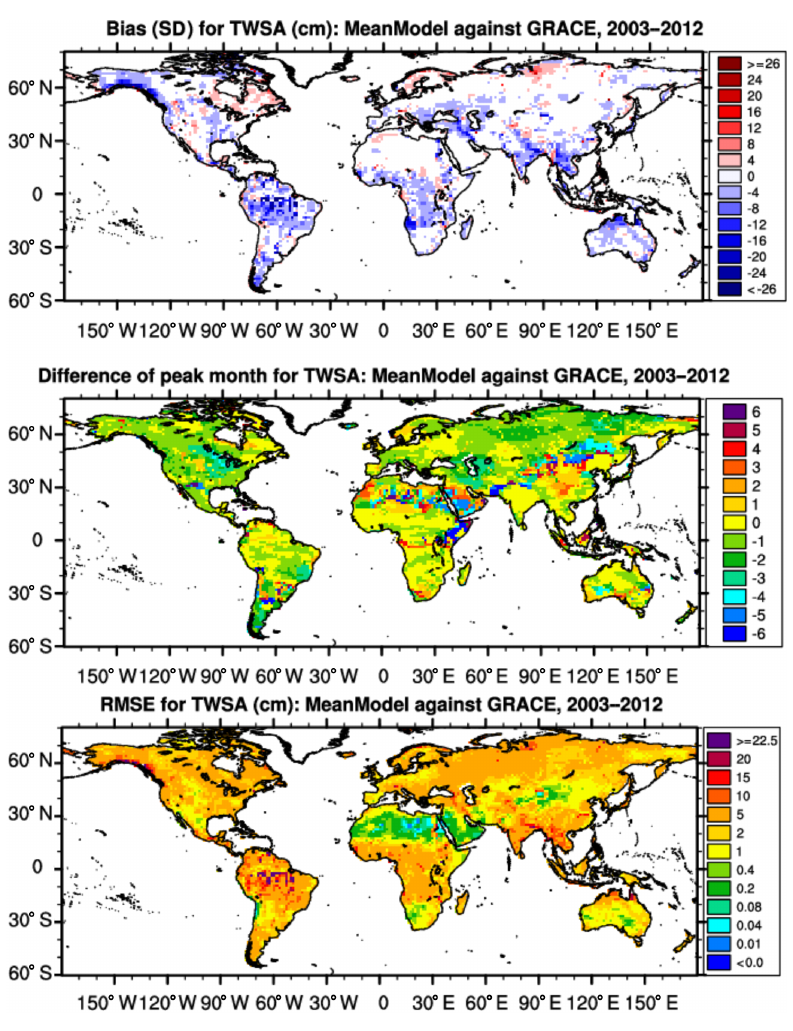
Figure 5. Terrestrial water storage anomaly metrics for the ensemble mean, from top to bottom: SD of bias, phase difference (months) and root mean square error. Table 5. Model mean evapotranspiration compared to the MODIS and GLEAM-V2a/GLEAM-V3b products. The difference in model mean annual ET in the last three rows is due to different periods used for the comparison (GLEAM-V2a 1980–2011, GLEAM-V3b 2003–2012, MODIS